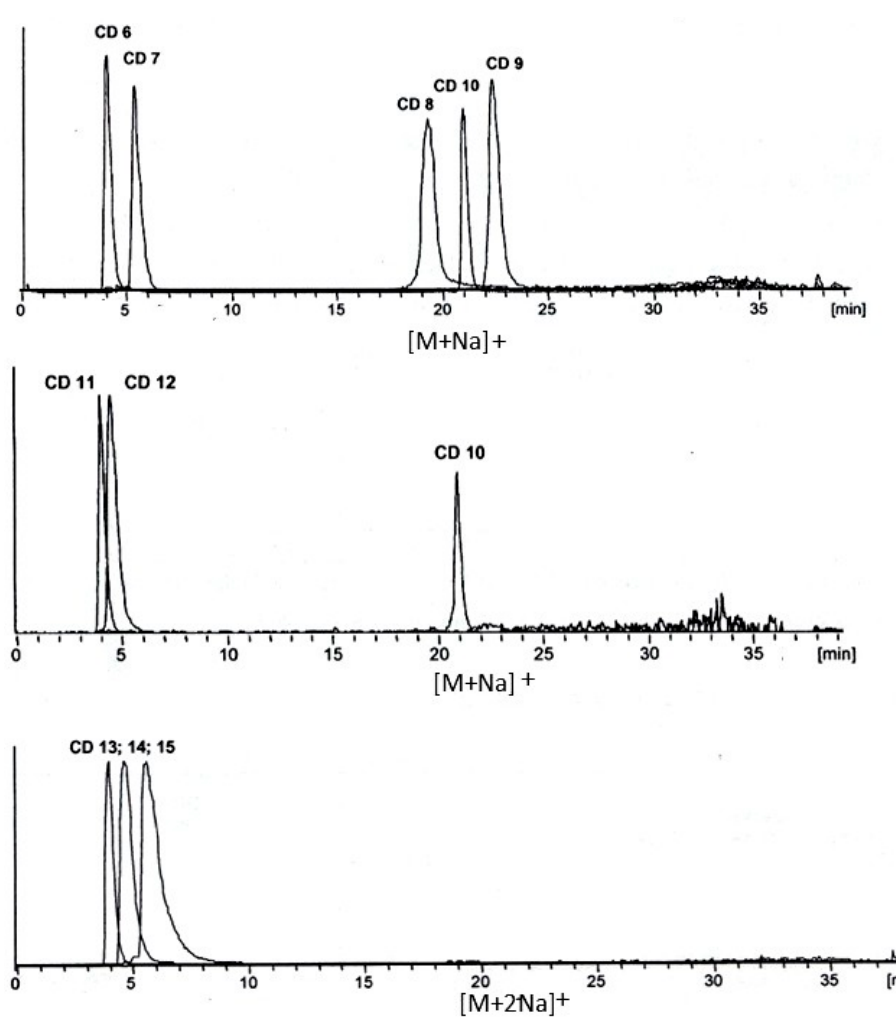
Figure 27. Overlaid LC-ESI-MS traces of the selective separation of CD6-CD15 sodium ion adducts on C 60 on a 250 × 4 mm I.D. stainless steel column packed with silica-bonded C 60 stationary phase, 0.5 mL/min water to acetonitrile/tetrahydrofuran gradient elution, 25 °C [110]. Reproduced from A. Bogdanski,